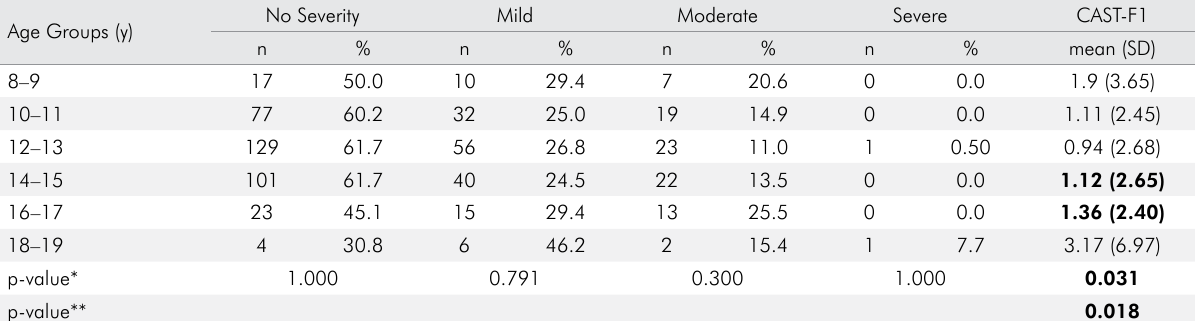
Table 5. Distribution of severity formula CAST-F1 and its categories, by age group. Age Groups (y)